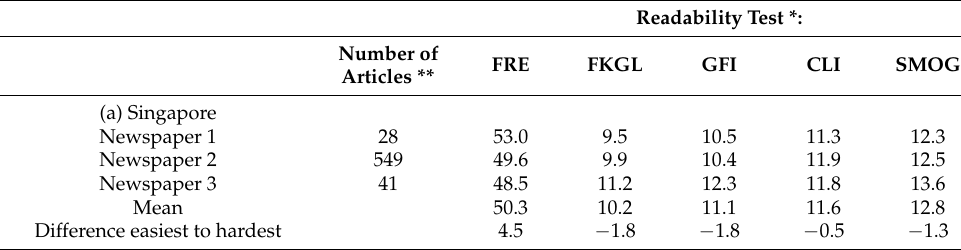
Table 5. Readability scores of major newspapers by